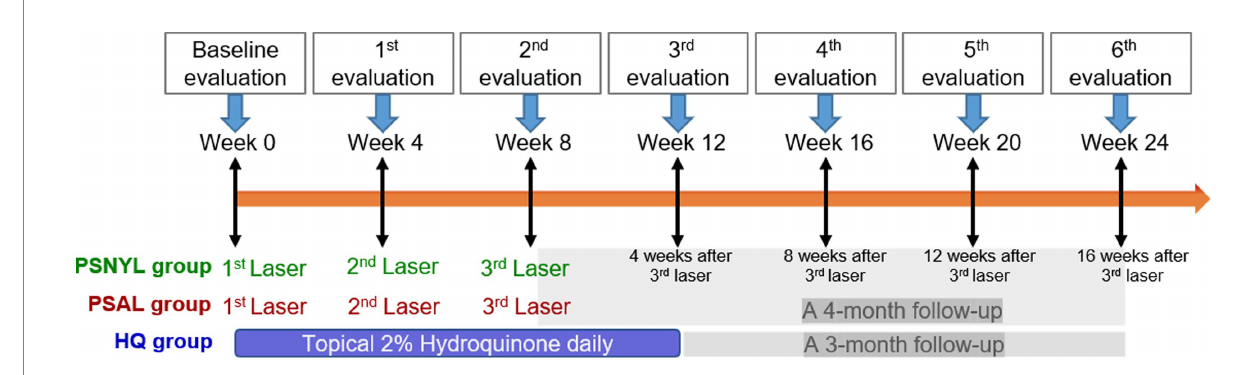
FIGURE 2 Study design. PSNYL, picosecond Nd:YAG laser (1,064 nm); PSAL, picosecond alexandrite laser (755 nm); HQ, hydroquinone